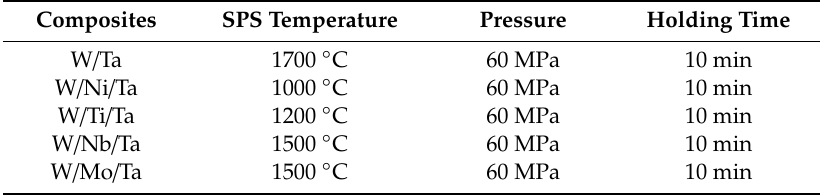
Table 2. The SPS conditions of different W-Ta laminates.